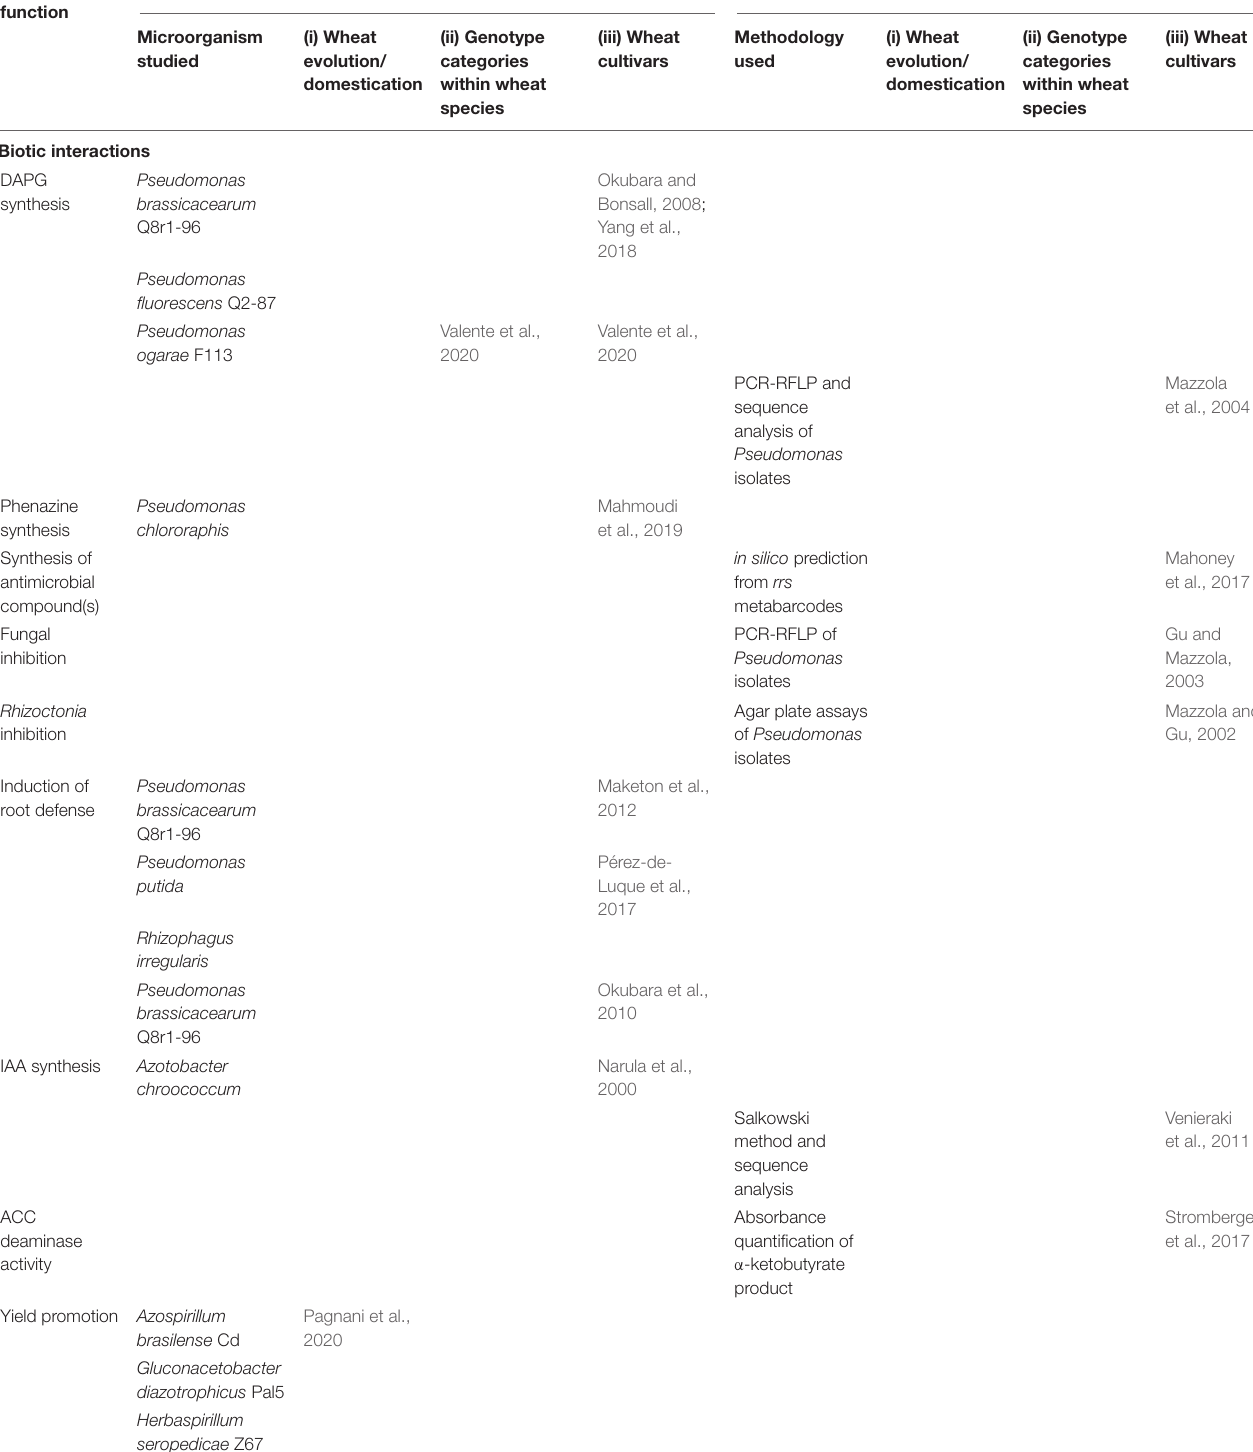
TABLE 4 | Literature comparisons of root-associated microbial functional groups considering (i) wheat of different species, wild or domesticated, (ii) landraces, ancient, or modern varieties within wheat species, and (iii) different modern cultivars within wheat species. Microbial Analysis of individual microorganisms Analysis of functional function